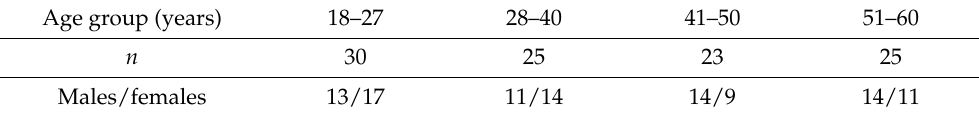
Table 1. Distribution of the 103 participants across the four age groups by